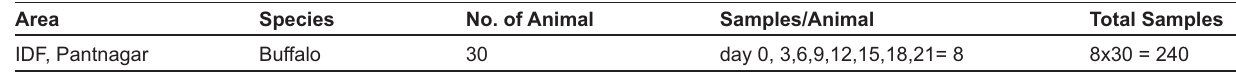
Table-1. Details of samples studied.